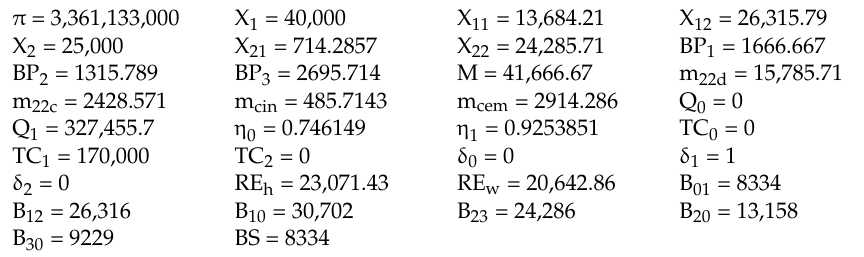
Table 4. The optimal solution in mixed integer programming model (MIP).